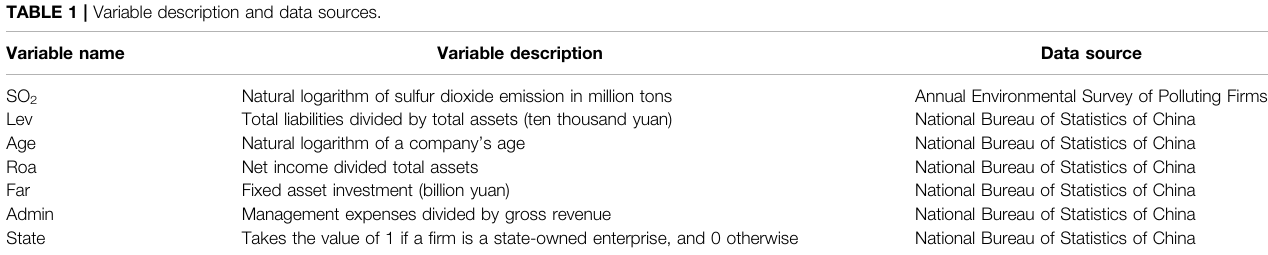
TABLE 1 | Variable description and data